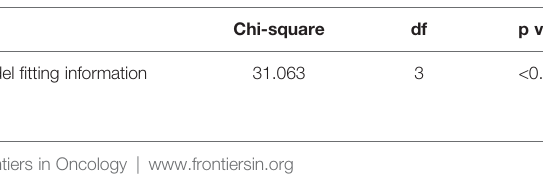
TABLE 4A | Ordinal multicategorical logistic regression of validation